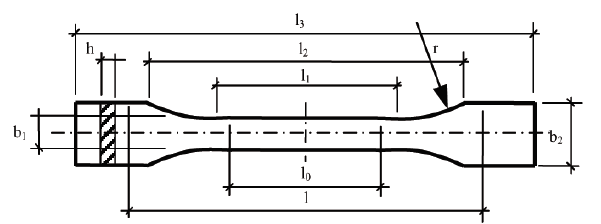
Figure 1: Specimen for material tests of chosen adhesives.